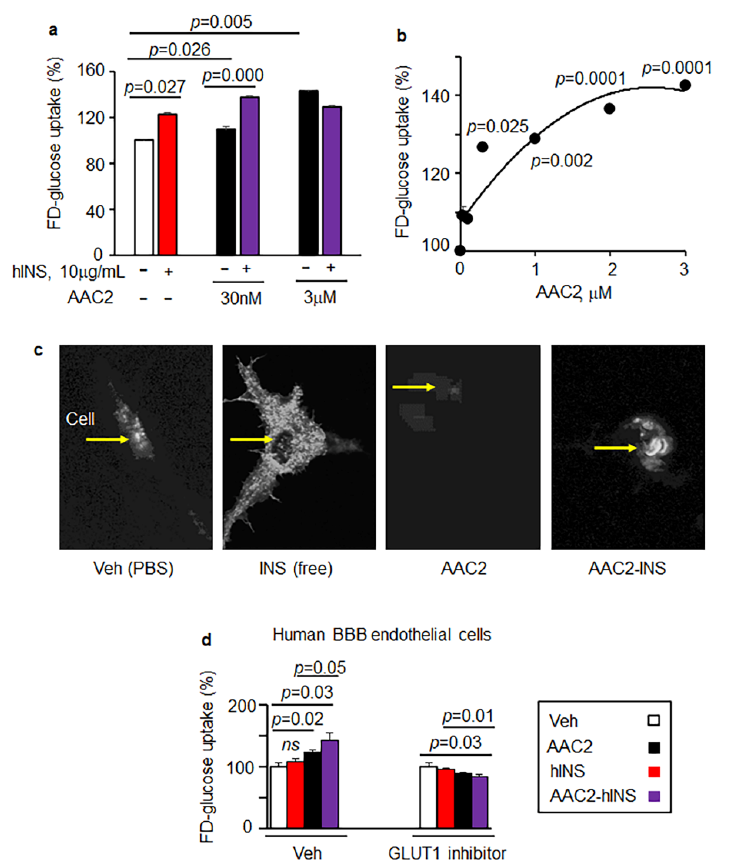
Figure 3. AAC2 ‐ hINS increases glucose uptake in 3T3 ‐ L1 preadipocytes and human BBB endothelial cells via GLUT4 and GLUT1. ( a ) FD ‐ glucose uptake in mouse 3T3 ‐ L1 preadipocytes ( n = 24 per treatment) treated with vehicle (Veh; PBS, open bar) or hINS (1.7 μ M, red bar) or AAC2 (0.03 and 3 μ M black bar) or AAC2 ‐ hINS (purple bar) with the respective concentration of AAC2 and a constant hINS concentration. After 2 h 15 min starvation, FD glucose and treatment reagents were added for an additional 85 min of incubation. Data (%) were normalized to FD ‐ glucose uptake in control (Veh) 3T3 ‐ L1 cells (100%). Student’s independent t ‐ test for all tests in figure. ( b ) AAC2 dose ‐ dependent uptake FD ‐ glucose in 3T3 ‐ L1 preadipocytes. Data are shown as % of increase compared to non ‐ stimulated cells. ( c ) Non ‐ differentiated NIH ‐ 3T3 cells were transiently transfected with GLUT4 ‐ GFP. Translocation of GLUT4 ‐ GFP (white, yellow arrow) cytosol to the membrane after stimulation with Veh (PBS), hINS (10 μ g/mL), AAC2 (10 μ M), or AAC2 ‐ hINS was demonstrated using confocal microscopy (60× magnification). ( d ) FD ‐ glucose uptake in human brain endothelial cells ( n = 7 per treatment) treated with vehicle (Veh; PBS, open bar) or hINS (1.7 μ M, red bar) or AAC2 (0.1 μ M black bar), or AAC2 ‐ hINS (purple bar) in the presence and absence of GLUT1 inhibitor (BAY ‐ 876; 10 nM in DMSO). Cells were pre ‐ treated with or without BAY ‐ 876 for 40 min and then FD glucose and treatment reagents were added for an additional 50 min of incubation. Data (%) were normal ‐ ized to FD ‐ glucose uptake in control (Veh without inhibitor, 100%). 3.3. Free AAC2, Free hINS, and AAC2 ‐ hINS Rescued STZ ‐ Treated Mice from Death Next, we investigated the effects of free and bound AAC2 and hINS in vivo under insulin ‐ deficient conditions induced by streptozotocin (STZ) ‐ mediated death of the pancreatic beta cells [36]. We used hINS for treatments to distinguish between endogenous and therapeutic insulin. We injected mice every 72 h with free hINS, AAC2, or hINS bound to AAC2 prior to the treatment (AAC2 ‐ hINS) to assess the duration of therapeutic action for each formulation. Given that the improved glucose uptake efficacy in 3T3 ‐ L1 cells has been observed at nanomolar concentrations of AAC2 (30 nM) and